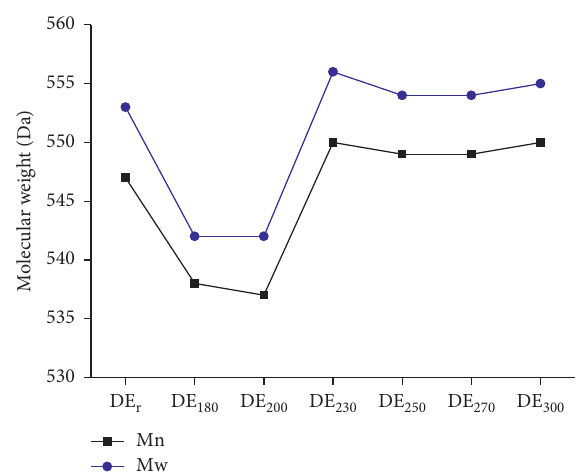
Figure 3: Molecular weights of oil samples.